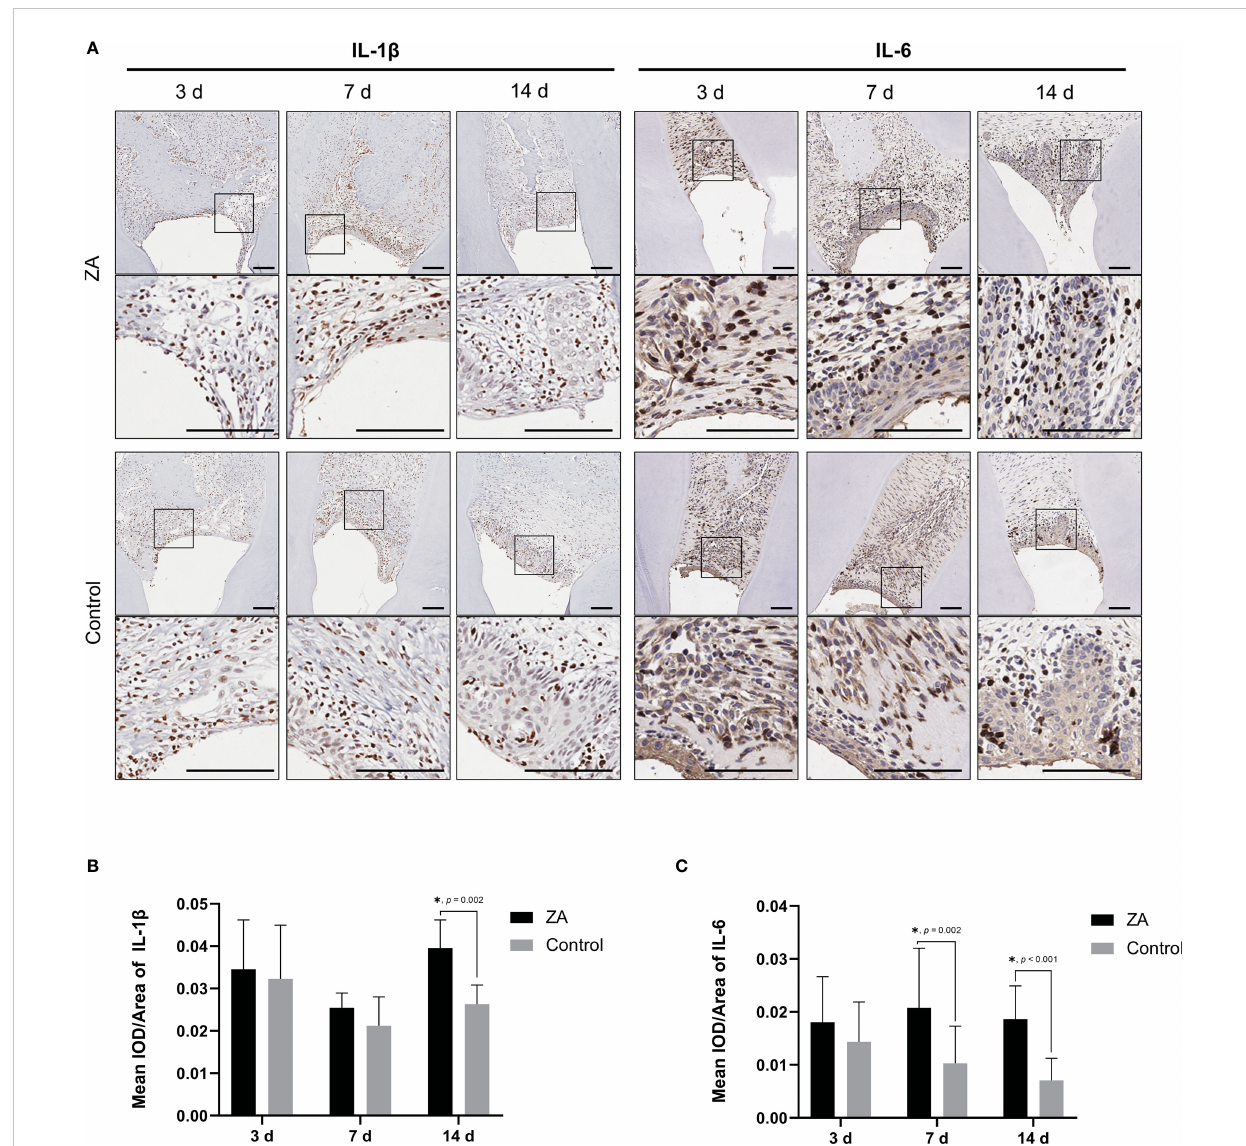
FIGURE 7 Expression of IL-1 b and IL-6 in the ZA group and the control group. (A) Representative immunohistochemical staining of IL-1 b and IL-6 in gingival tissue sections of both groups. The images in the second panel of each group are enlarged views of the boxed areas in the above images. Scale bars = 100 m m. (B) Mean IOD/Area of IL-1 b in the ZA group and the control group on days 3, 7, and 14. n = 4 at each time point. (C) Mean IOD/Area of IL-6 in the ZA group and the control group on days 3, 7, and 14. n = 4 at each time point. Values represent mean ± SD. *p